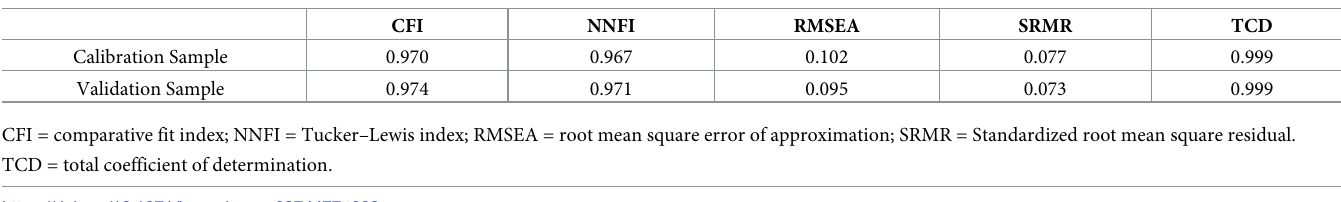
Table 2. Fit indices in the calibration and validation